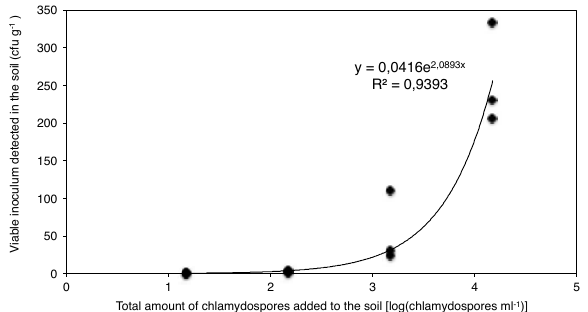
Figure 1. Relationship between numbers of Phytophthora cinnamomi chlamydospores added to soil [log (chlamydo- spores ml -1 )] and viable chlamydospores detected (cfu g -1 ). Dots are the obtained values and the line the adjusted ex- ponential curve